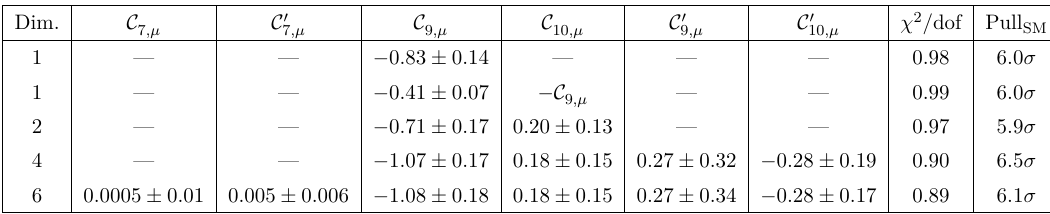
Table 10 . Best fit values and 1 σ uncertainties of the Wilson coefficients from a fit also including the observables listed in table 8 for different new physics scenarios. We also provide the χ 2 / dof value and respective pull from the SM